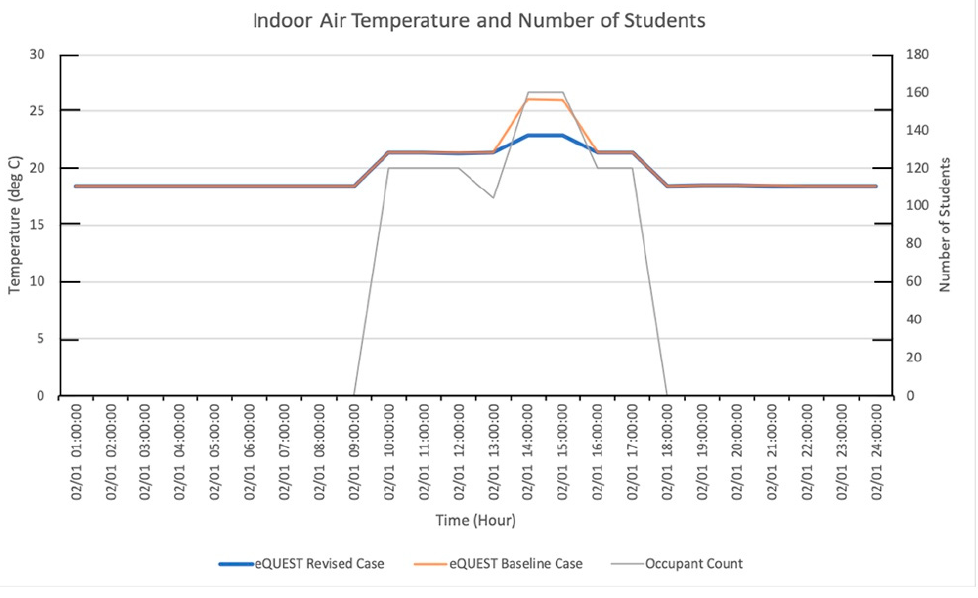
Figure 12. eQUEST temperature results of a day, showing a reduction in indoor air temperature.